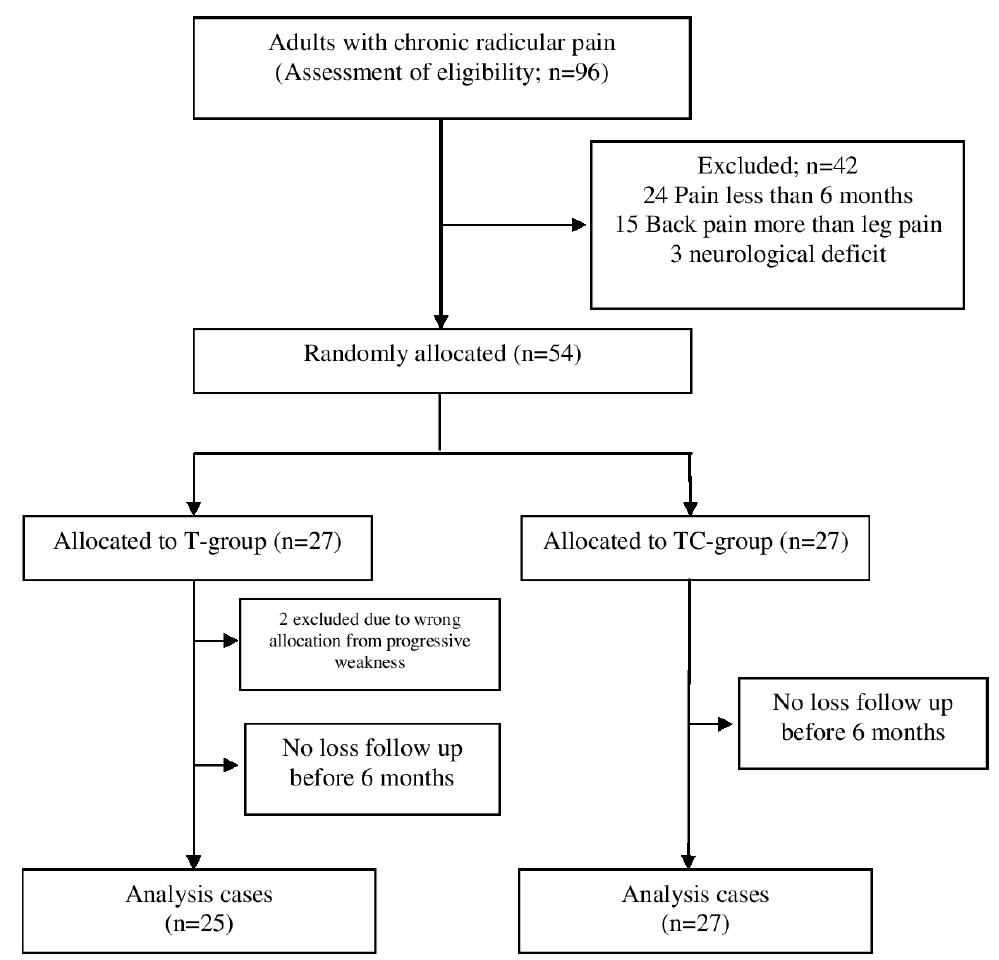
Figure 3. Flow diagram of enrolled patients.Flow diagram of enrolled